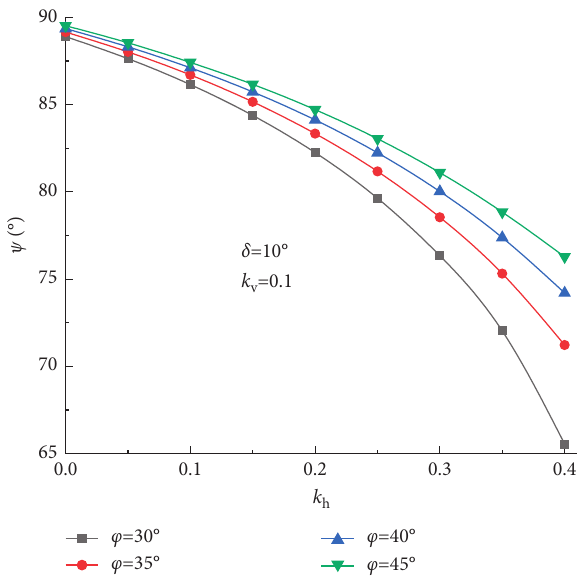
Figure 7: θ curve of variation with (k)